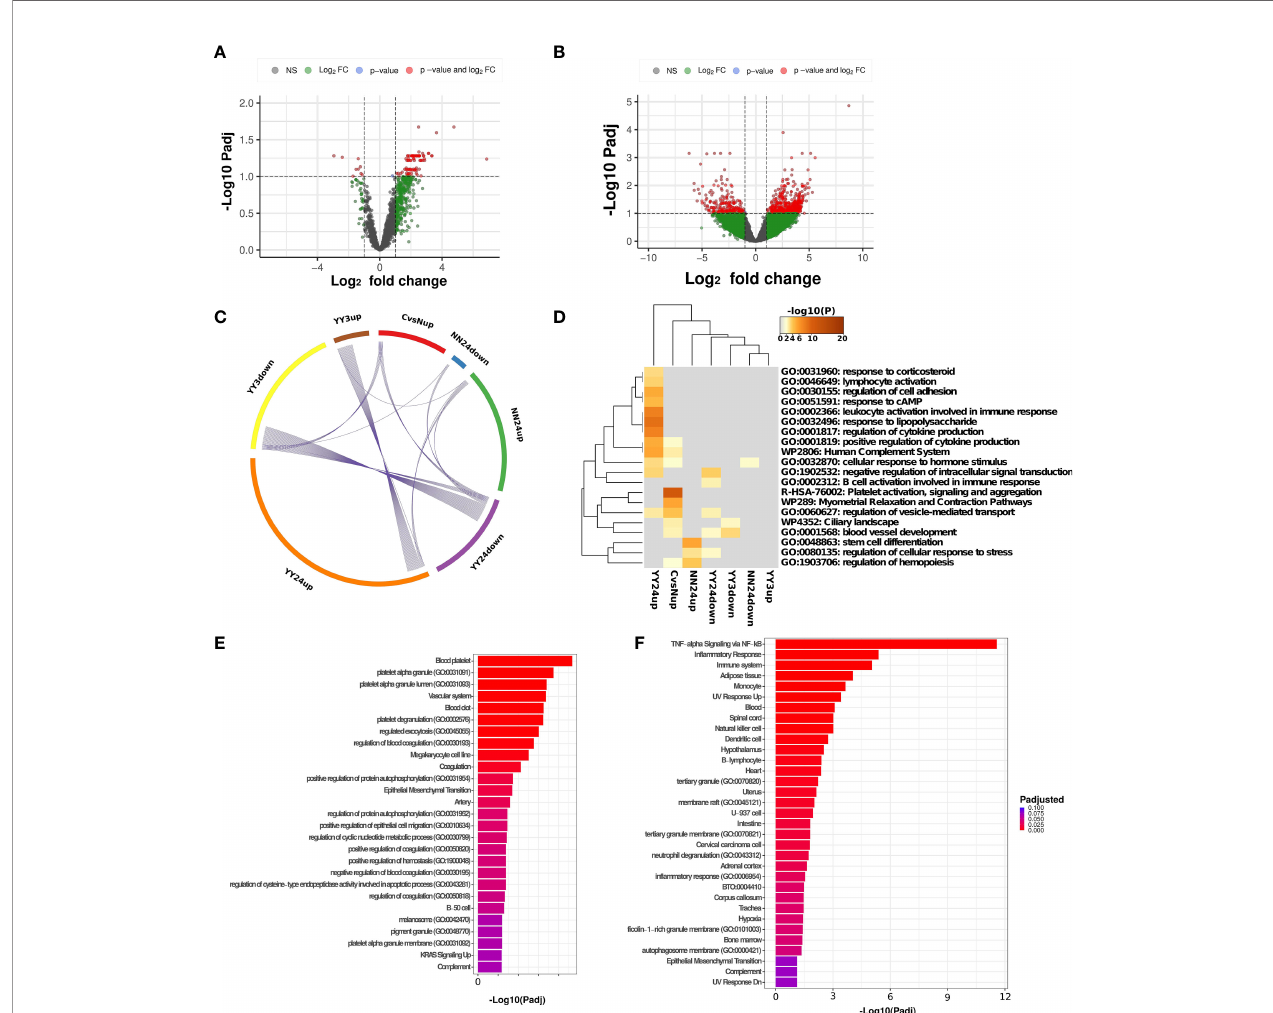
FIGURE 3 | Differential expression analysis. (A) Volcano plot representing signi fi cantly differentially expressed genes in Cancer vs. Healthy patients at baseline. Genes are considered signi fi cant if they pass the FDR-corrected p-value of 0.1 and show an absolute fold difference of at least 2. (B) Volcano plot representing signi fi cantly differentially expressed genes in APG-treated Cancer patients after 24h vs. baseline. Genes are considered signi fi cant if they pass the FDR-corrected p-value of 0.1 and show an absolute fold difference of at least 2. (C) Overlap of differentially expressed genes (DEGs) between different comparisons and (D) heatmap showing the overlap in overrepresented terms between different comparisons. CvsNup = Cancer vs. Healthy patients before treatment, upregulated genes; YY3up/down APG-treated Cancer patients at 3h post-treatment vs. pre-treatment, up or downregulated genes; YY24up/down APG-treated Cancer patients at 24h post-treatment vs. pre-treatment, up or downregulated genes; NN24up/down Placebo-treated healthy patients at 24h post-treatment vs. pre-treatment, up or downregulated genes. (E) Bar plot showing the top most signi fi cantly enriched terms in cancer vs. healthy patients at baseline. The dataset is a combination of GO Biological Processes, GO cellular component, MsigDb and Jensen tissues databases. (F) Bar plot showing the top most signi fi cantly enriched terms in APG-treated cancer patients 24h post-treatment vs. pre-treatment. The dataset is a combination of GO Biological Processes, GO cellular component, MsigDb and Jensen tissues